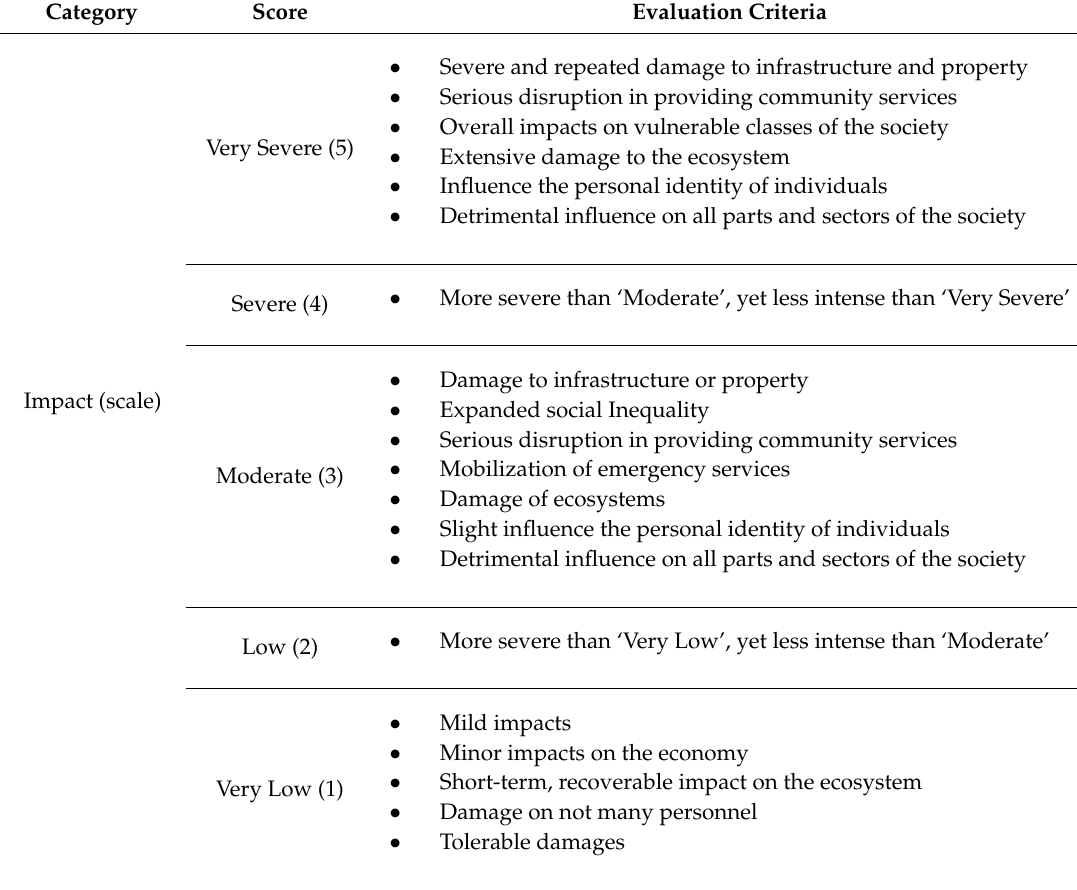
Table 2. Guidance on impacts